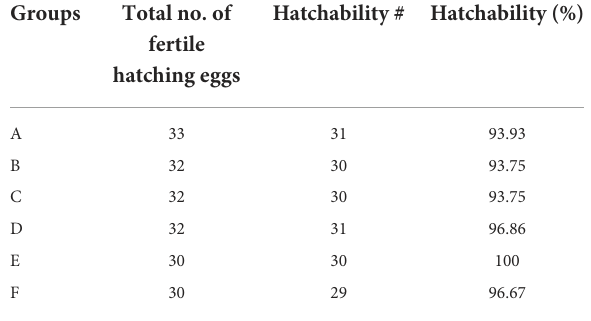
administered live IBD vaccines in ovo and post-hatch period. Groups Total no. of fertile hatching